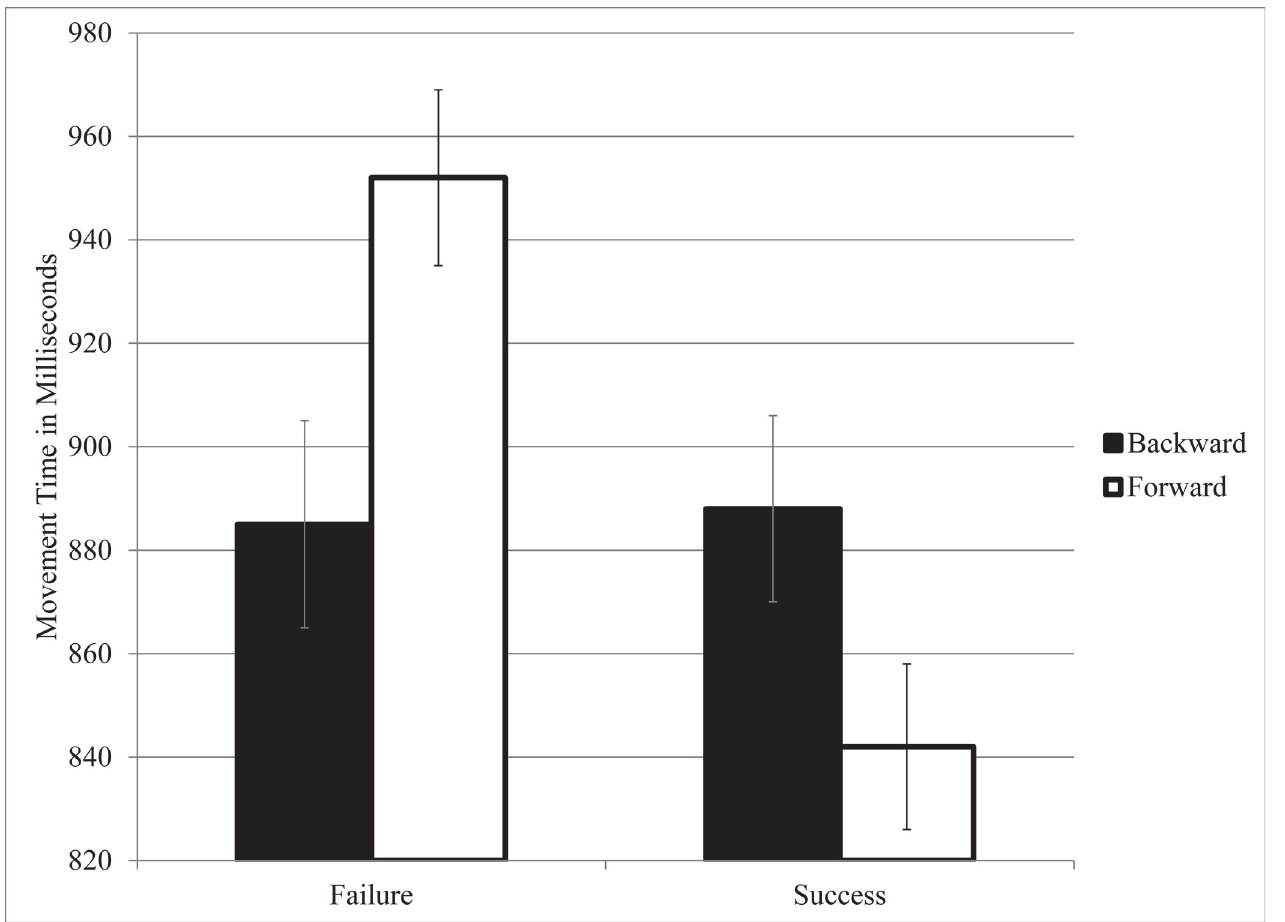
Fig 1. Movement Times with Standard Errors as a Function of Word Category (Success versus Failure) and Movement Direction (Forward versus Backward), Experiment